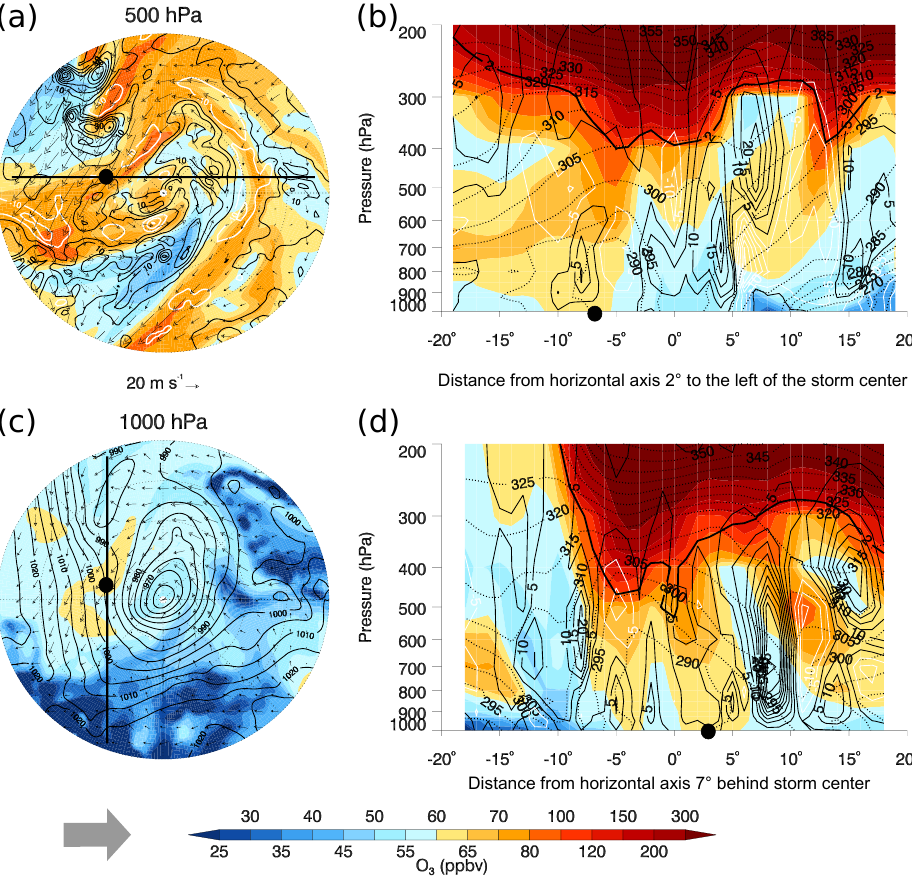
Figure 7. N1 cyclone on 5 March 2007 at 00:00UTC, similar to Fig. 6, except 24h later. The additional thick vertical lines ( a , c ) indicate the location of the vertical transects (b) 2 ◦ to the north of the cyclone center and (d) 7 ◦ behind the cyclone center, respectively. The cross sections have positive axis values to the east ( a , b ) and to the north ( c , d ). The approximate location of Mace Head is indicated by the large black dot. The cyclone has been rotated in order that the direction of cyclone propagation is toward the right, indicated by the grey